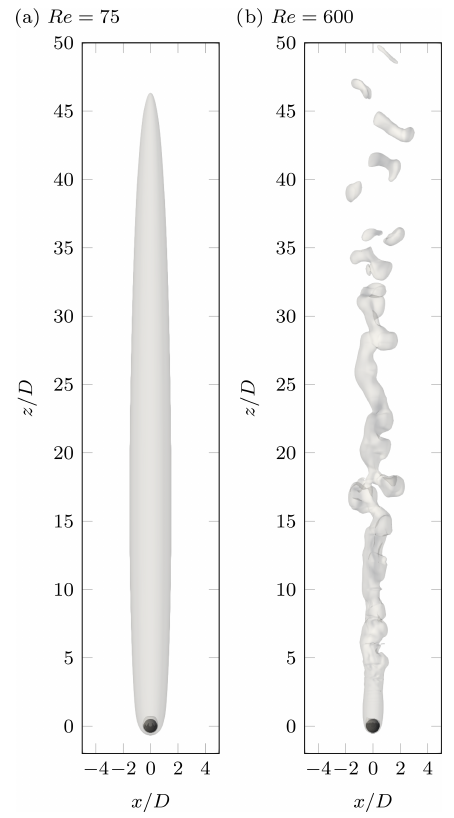
Figure 4. Isosurfaces of supersaturation in the wake at T ∞ = − 15 ◦ C. The value of the isocontour is s i, ∞ + 0 . 02, i.e., two per- centage points higher than the ambient supersaturation. Two differ- ent wake regimes are depicted, which correspond to two different hydrometeor sizes in our framework. (a) Axisymmetric regime at Re = 75. (b) Chaotic regime at Re =